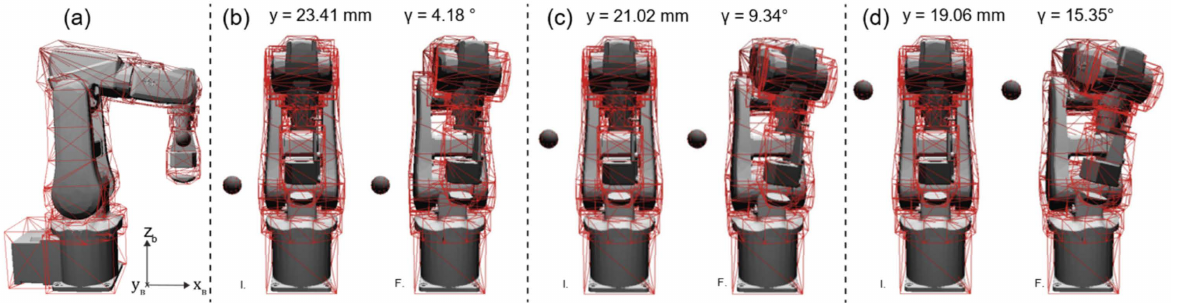
Figure 10. ( a ) Lateral view of the robotic manipulator with one obstacle. The direction of the base reference system axes is also reported. ( b ) The initial (I.) and final (F.) pose of the manipulator when the obstacle is placed at 350 mm on the z B coordinate. ( c ) The initial and final pose of the manipulator when the obstacle is placed at 450 mm on the z B coordinate. ( d ) The initial and final pose of the manipulator when the obstacle is placed at 550 mm on the z B